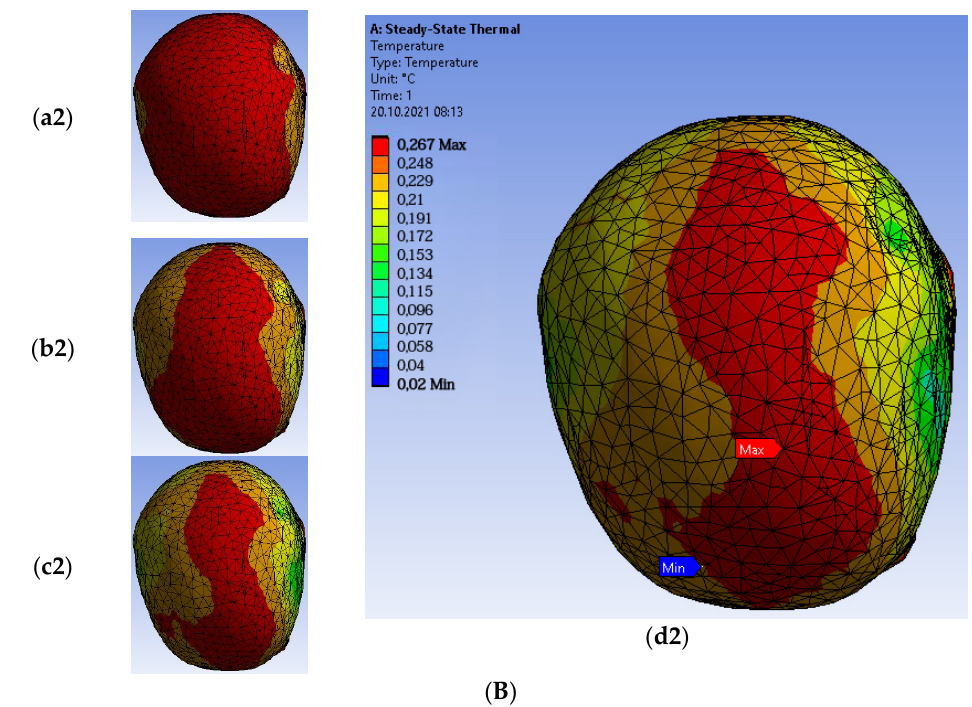
Figure 13. ( A ) the left side and heat transfer of the skull in ( a1 ) 0.3 s, ( b1 ) 0.6 s, ( c1 ) 0.9 s and ( d1 ) 1 s; ( B ) the top views and heat transfer of the skull in ( a2 ) 0.3 s, ( b2 ) 0.6 s, ( c2 ) 0.9 s and ( d2 ) 1 s.